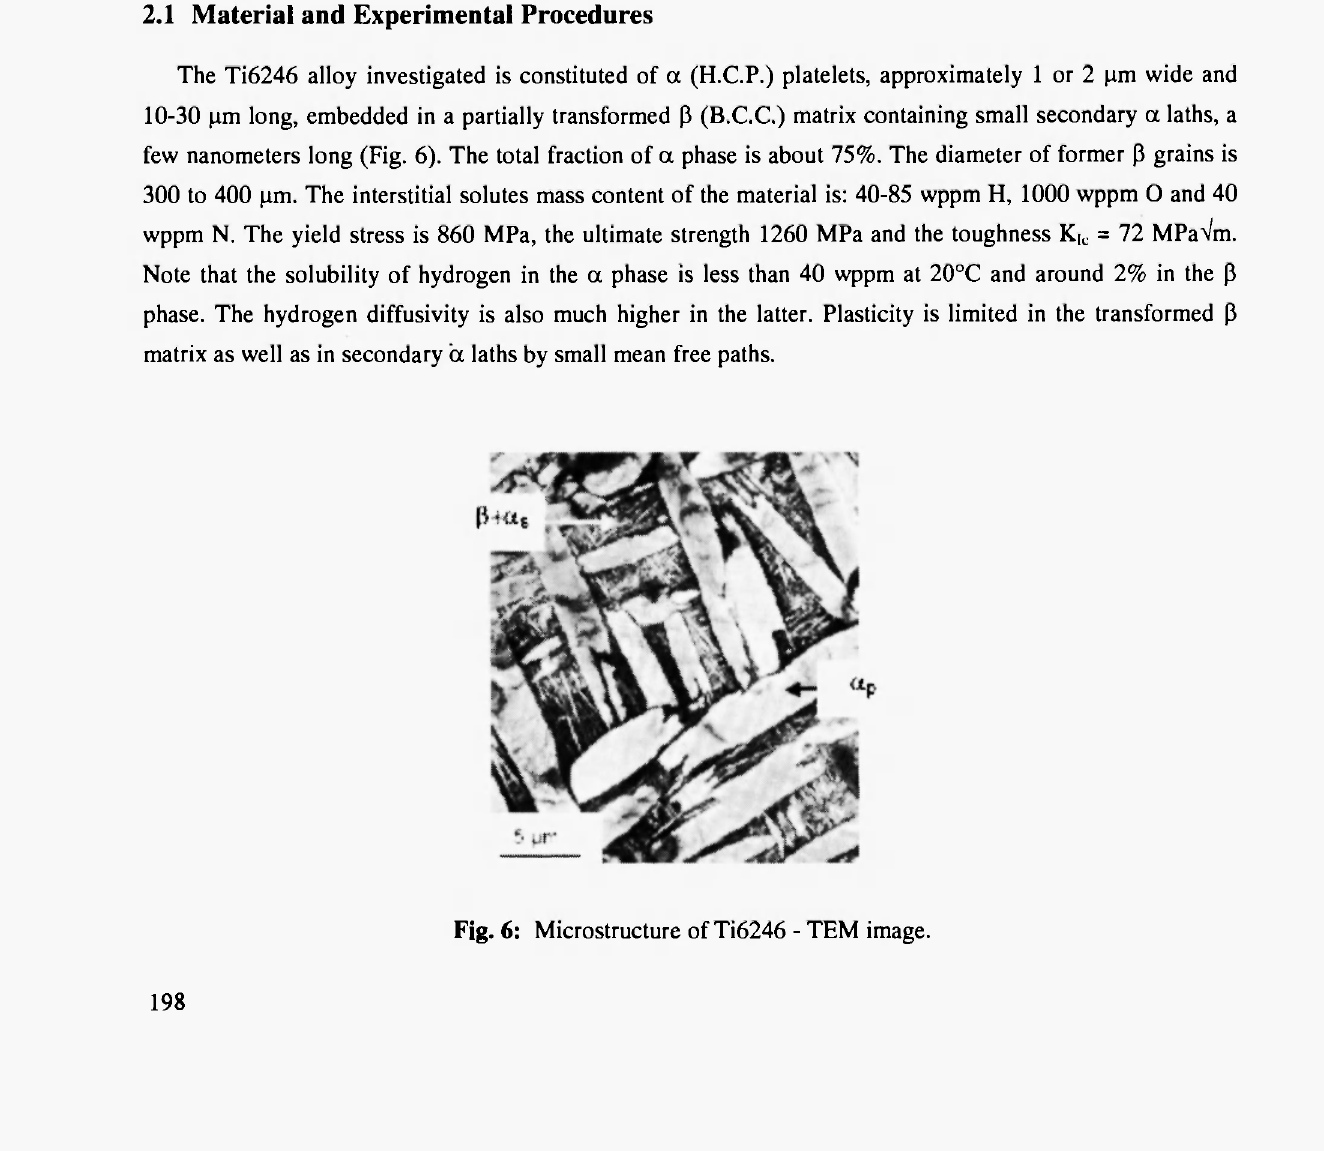
Fig. 5: Aspect of fracture surfaces formed under cyclic loading at high K, (a) in the Paris regime (b) in the abnormal regime.